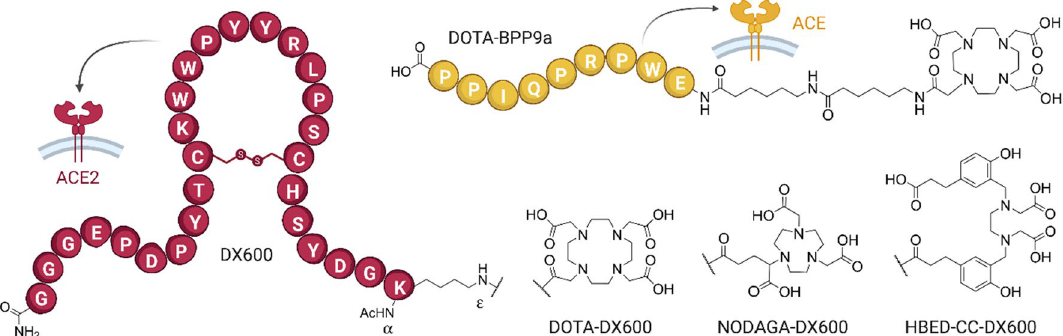
Fig. 1 Schematic structures of DOTA‑DX600, NODAGA‑DX600, HBED‑CC‑DX600 (red) for targeting ACE2 and DOTA‑BPP9a (yellow) for targeting